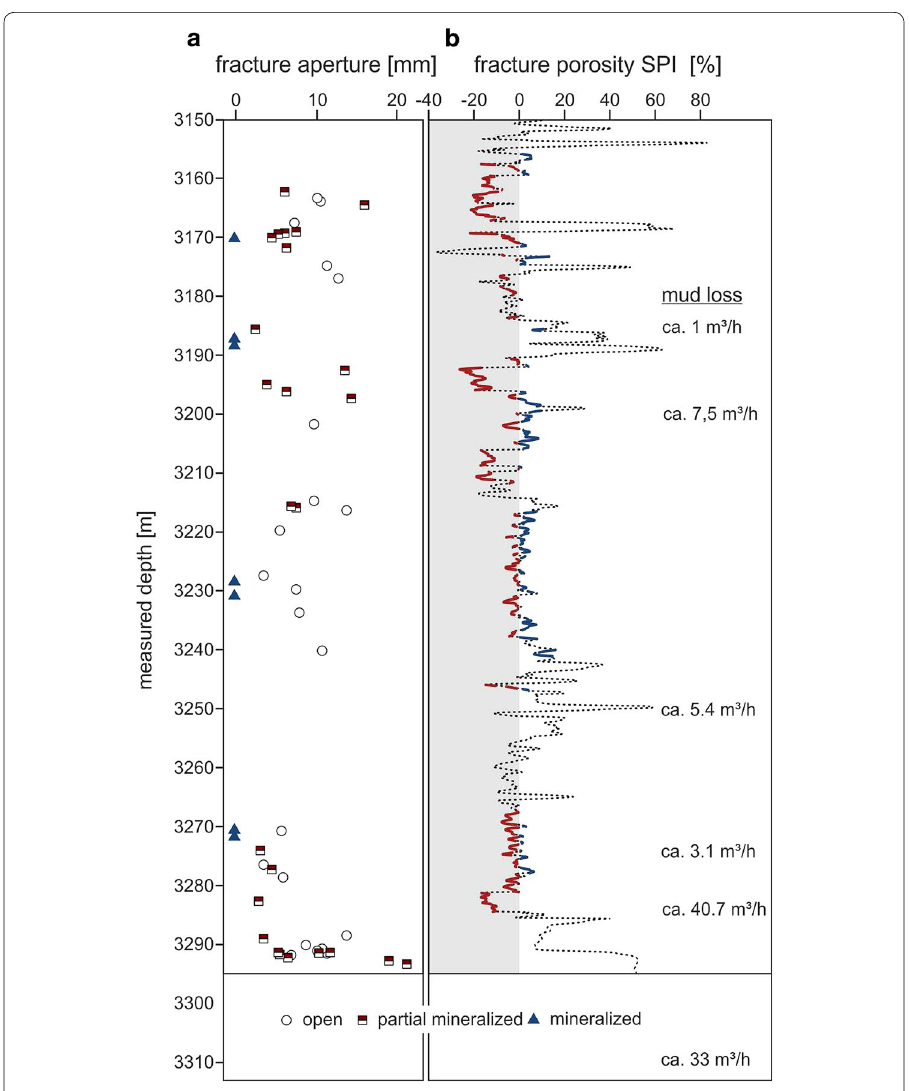
(secondary porosity index), and observed mud loss during the drilling operation, as a proxy for the structural permeability. The grey dotted lines show rejected data, e.g. data found to be biased by bad hole conditions, red bold lines negative and blue bold lines positive fracture